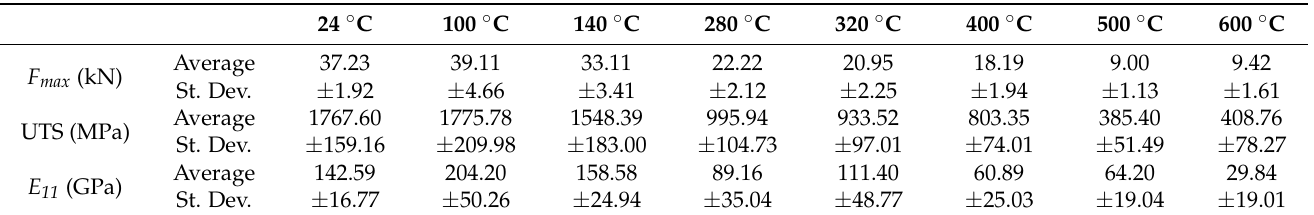
Figure 20. Stress (MPa) vs. strain (%) representative curves for each SS case. Table 6. Average and standard deviation values of maximum force (kN), ultimate tensile strength (UTS) (MPa), and longitudinal modulus \ E 11 (GPa), SS tests.